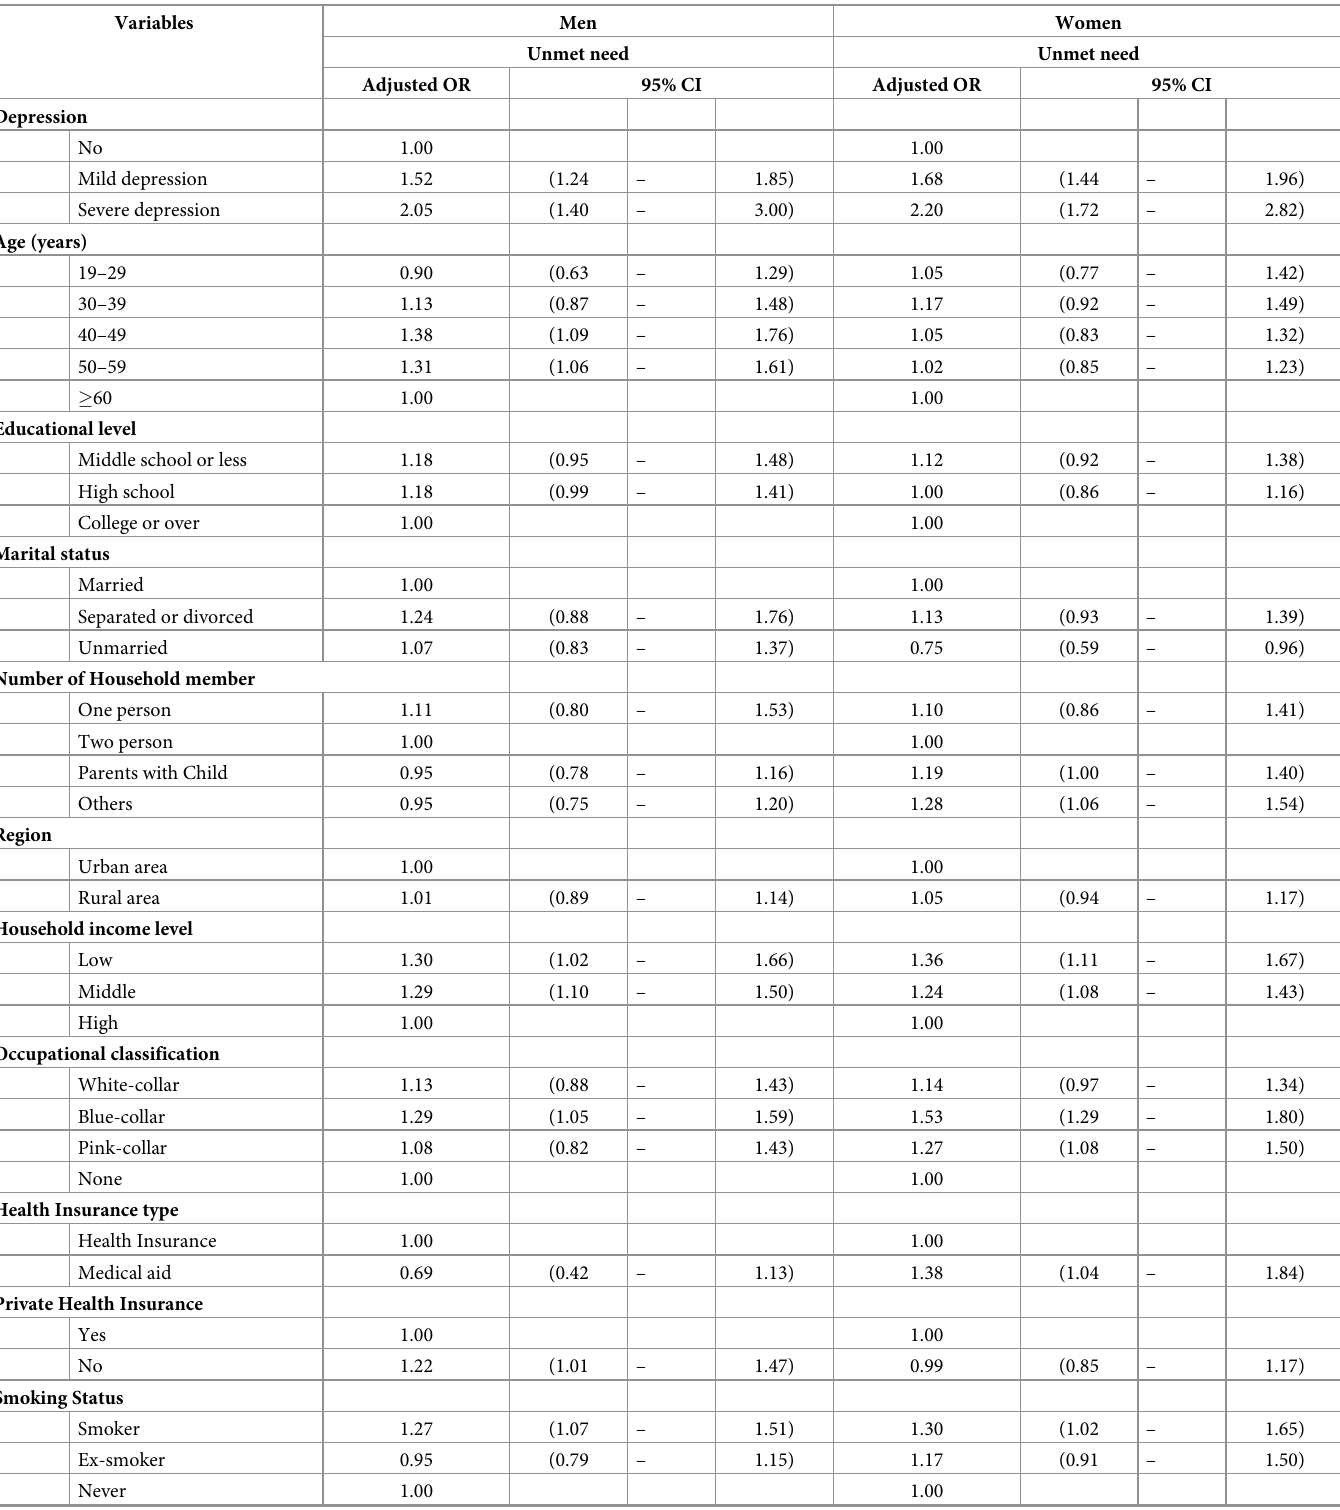
Table 2. Factors associated with unmet healthcare